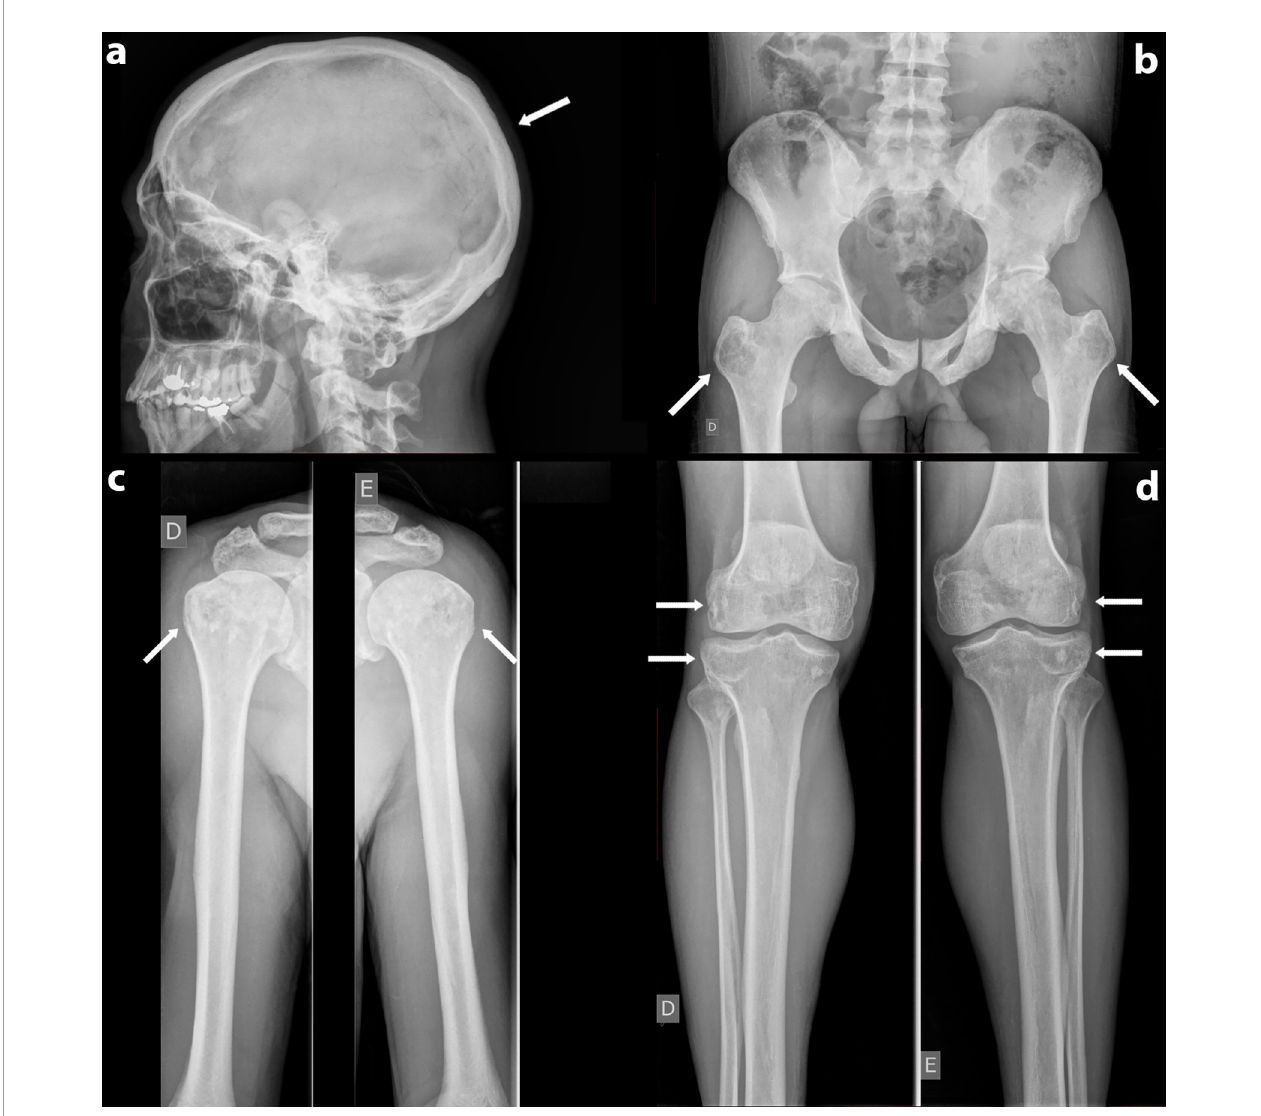
FIGURE 1 | (A) Normal skull radiography. (B) Anteroposterior radiography of the pelvis Symmetric radiolucency with cystic aspect in greater trochanter bilaterally. (C) Anteroposterior radiography of upper limbs- heterogeneous bone density in humeral heads bilaterally with the presence of sclerosis and radiolucent areas. (D) Anteroposterior radiography of lower limbs-pseudo-poikilosis (patchy sclerotic lesions) and radiolucency in distal metaphysis of right and left femur and in proximal region of tibia